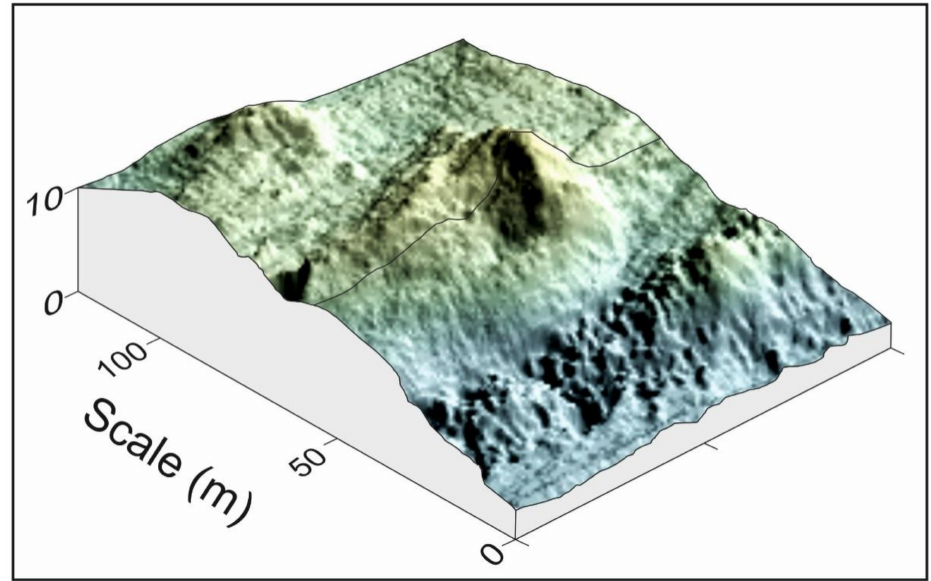
Figure 8. A 3D block diagram showing an individual cone displaying the morphology of a volcano. The location of this feature is highlighted in Figure